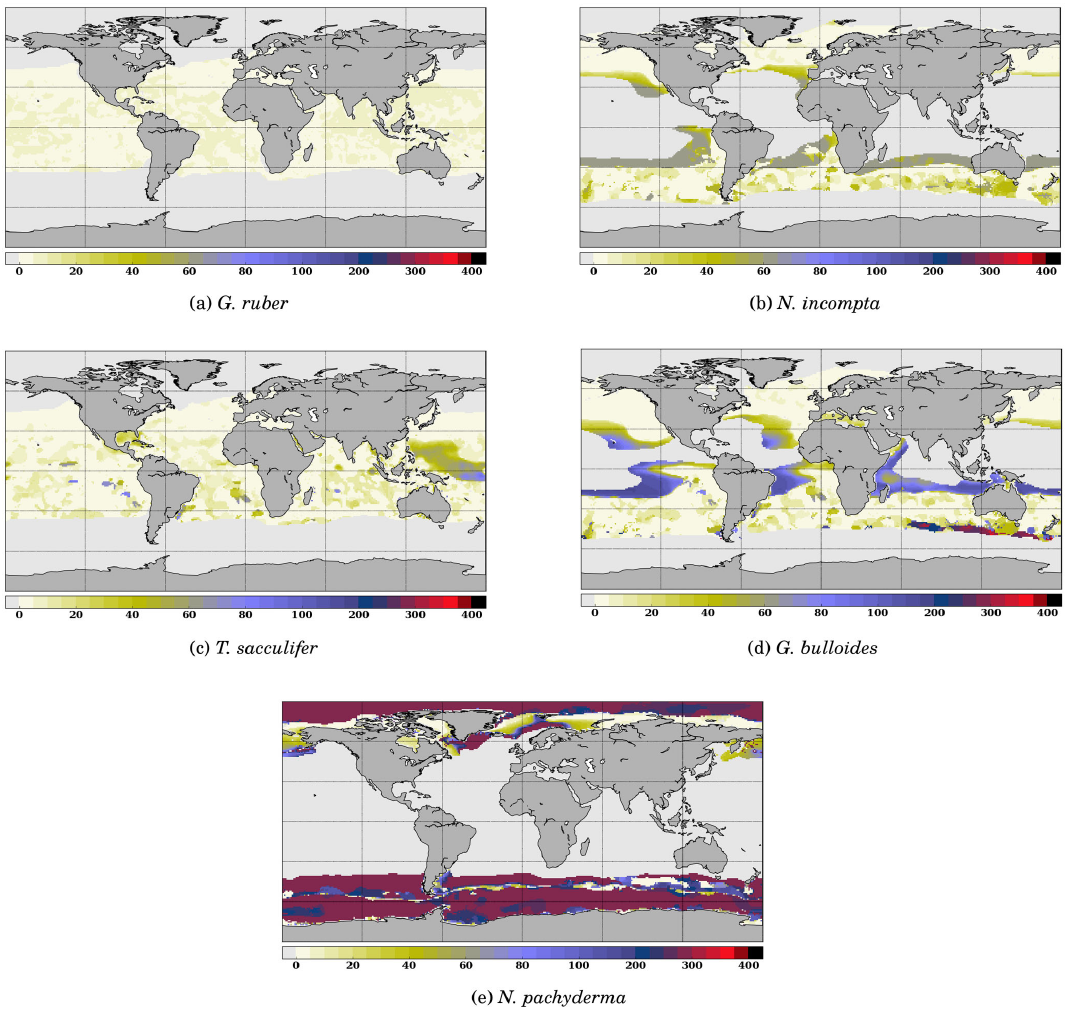
Figure 4. Depth of maximum growth for the species considered for the month of July. The color scale shows the depth in meters. Oceanic areas left in white correspond to areas where growth rates are below the threshold defined in Eq.